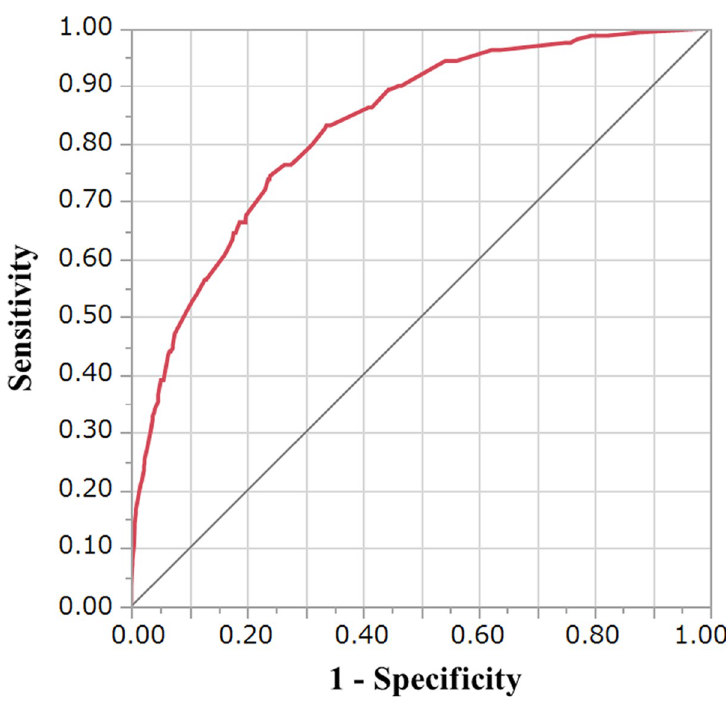
Fig 4. Receiver operating characteristic curve of the ANN model. The area under the receiver operating characteristic curve was 0.83.